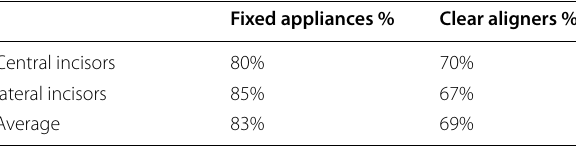
Table 5 Prevalence of root resorption in the two groups